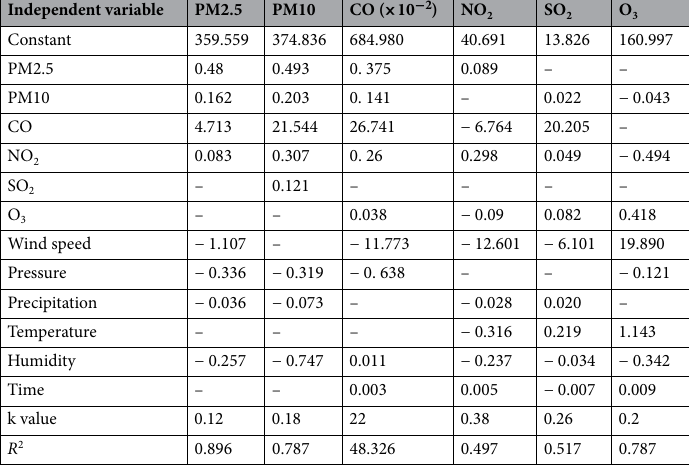
Table 3. Ridge regression model of six types of air pollutant concentrations. In the model, the dependent variable is the concentration of the six pollutants at the national control point, and the independent variable is the variable and time monitored by the self-built point (– represents the variables eliminated in the